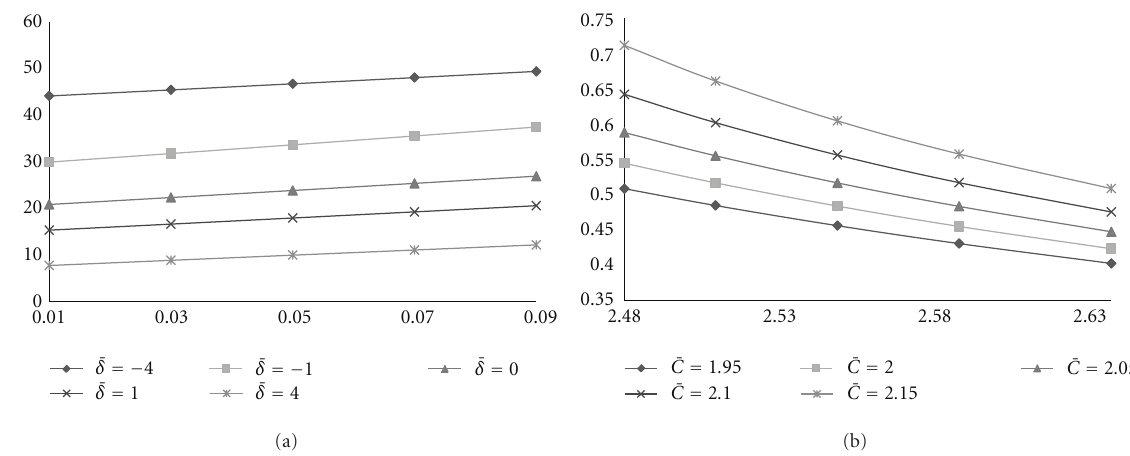
Figure 8: (a) Variation of load-carrying capacity with respect to s/κ and δ (b) Variation of load-carrying capacity with respect to B and C